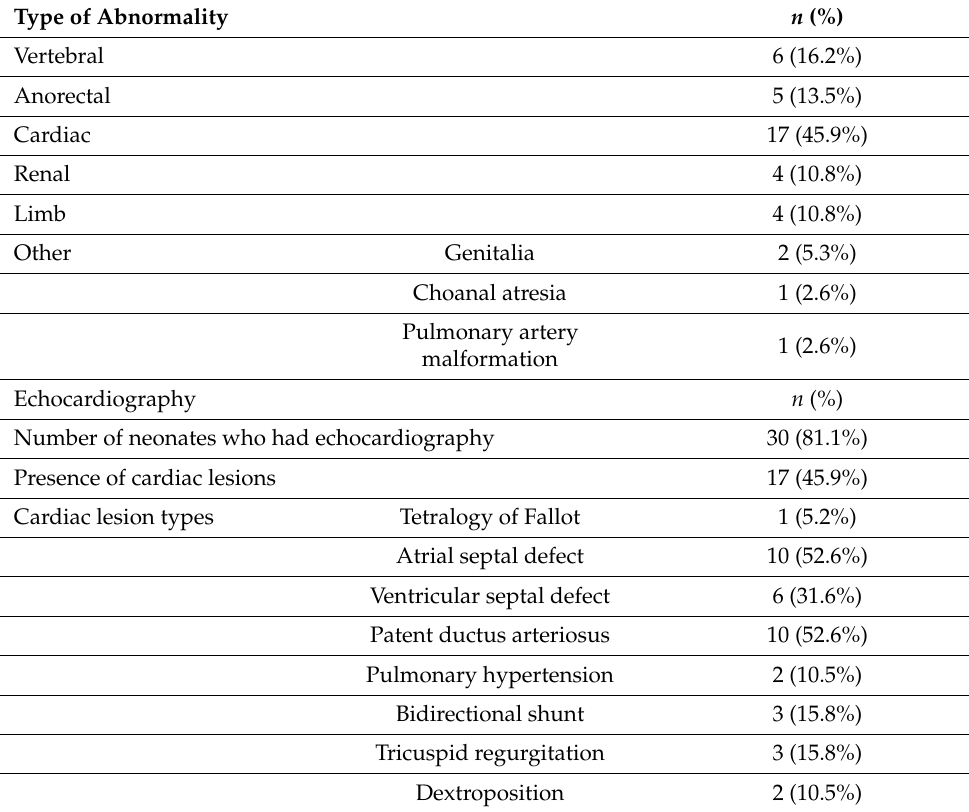
Table 2. Congenital abnormalities among neonates presenting for TOF